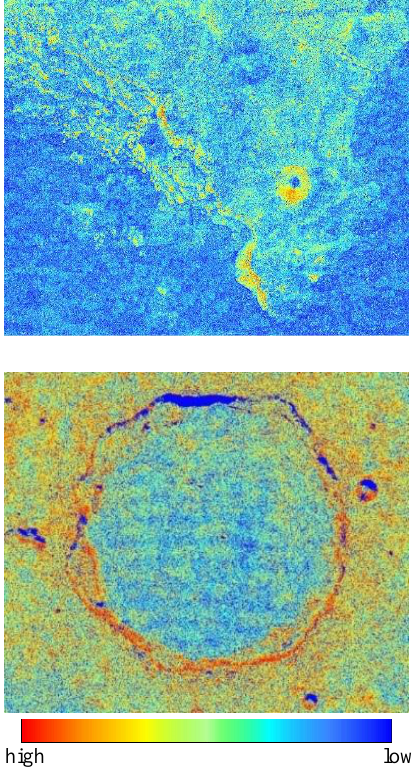
Figure 5. Results by using MSR of the tail of Montes Jura southeast (up) and Crater Plato (down)